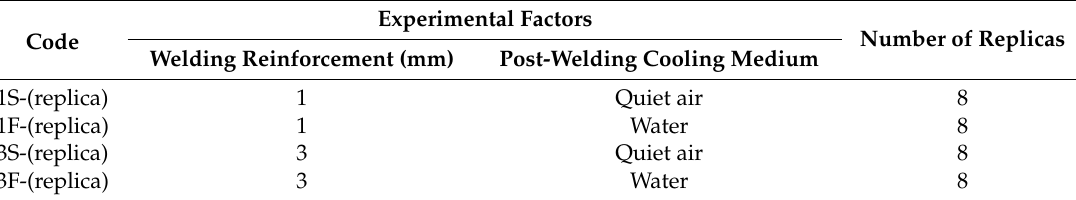
Table 1. Coding used for the uniaxial fatigue test specimens.